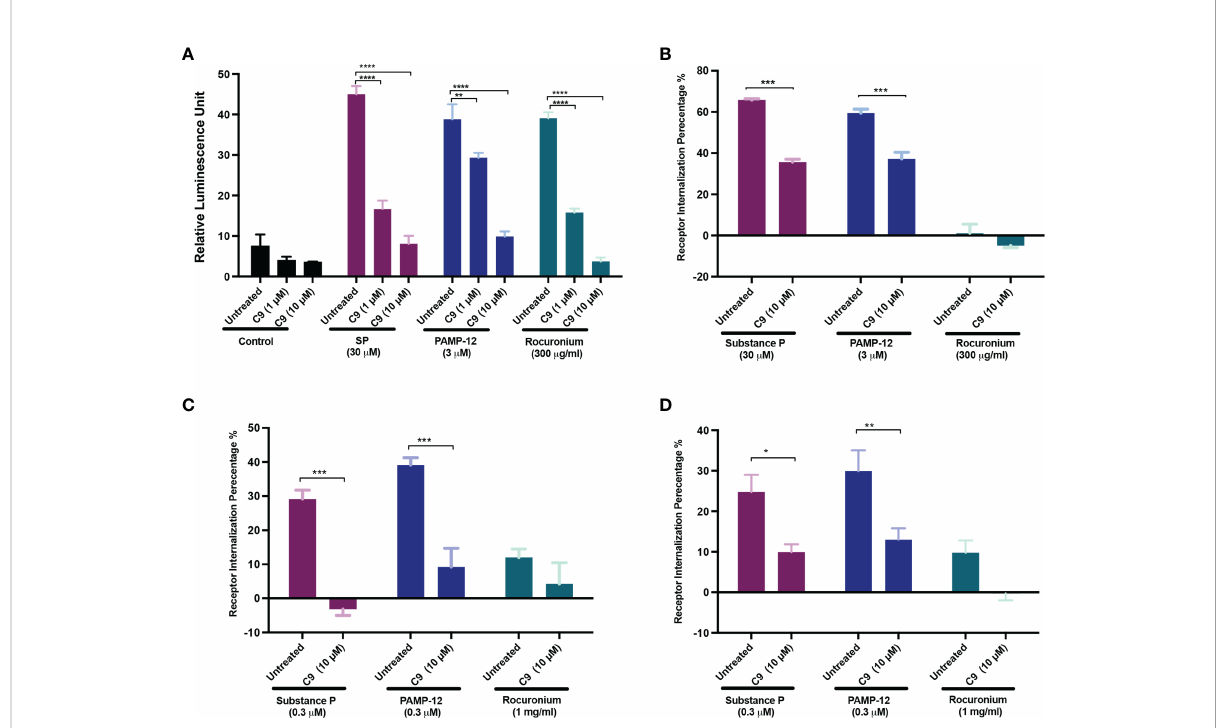
FIGURE 6 C9 inhibits MRGPRX2-mediated b -arrestin recruitment and receptor internalization. (A) HTLA-MRGPRX2 cells were preincubated with C9 (1 µM and 10 µM, 5 min) and then exposed to SP, PAMP-12, or rocuronium for 16h The medium was removed and substituted with the Bright-Glo solution (100 m l/ well) in a 96-well plate. b -arrestin translocation-mediated gene expression was quantitated as a relative luminescence unit. (B-D) Quantitative analysis of receptor internalization in (B) HTLA-MRGPRX2, (C) RBL-MRGPRX2, and (D) LAD2 cells. Cells were preincubated with C9 (10 µM, 5 min), exposed to buffer or MRGPRX2 agonists (30 min) and cell surface receptor expression was determined by fl ow cytometry. The percentage of receptor internalization was calculated using a mean fl uorescent intensity (MFI) in comparison to the untreated or vehicle controls. Data are expressed as mean ± SEM. Statistical signi fi cance was determined by two-way ANOVA test at a value * P < 0.05, ** P < 0.01, *** P < 0.001, and **** P <